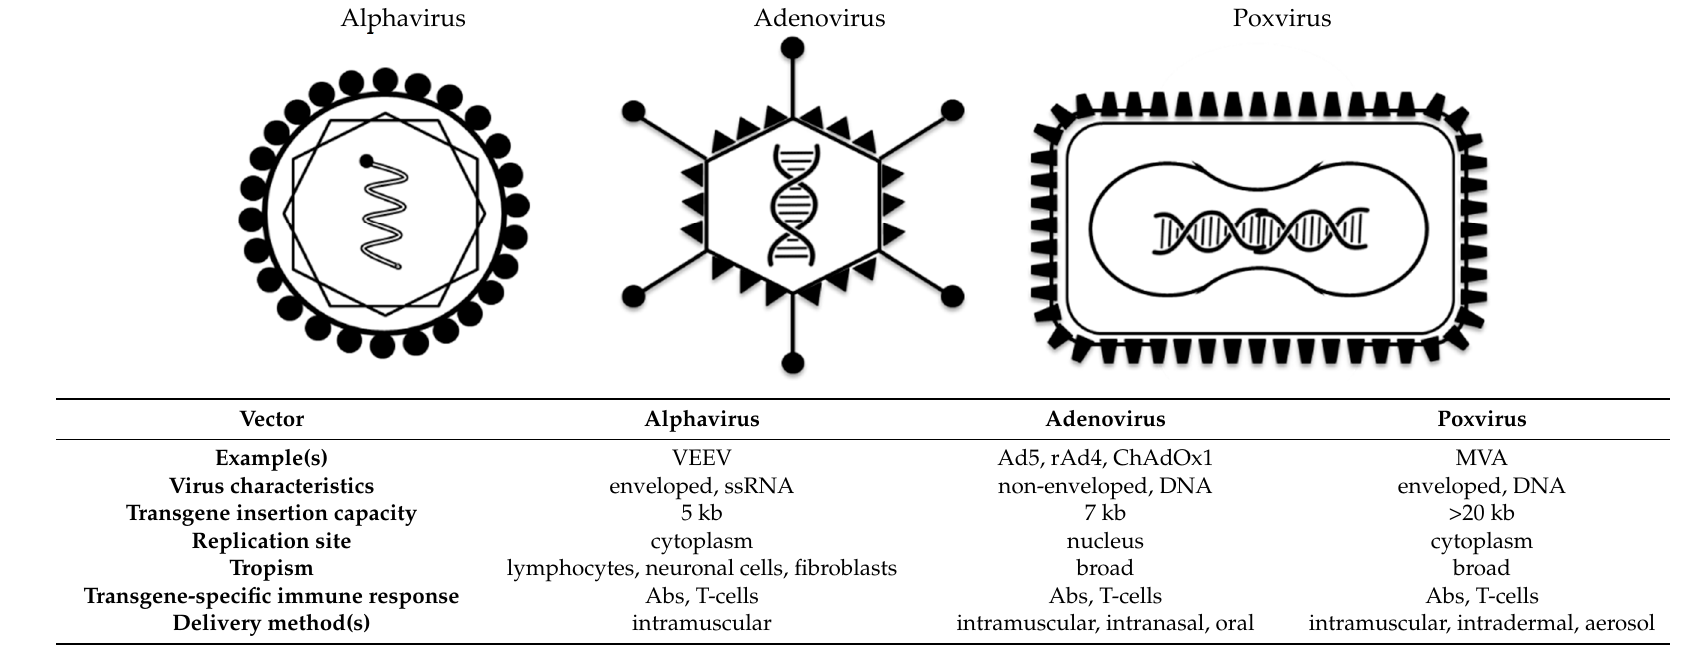
Table 1. Characteristics of viral vectors used in clinical trials for influenza.